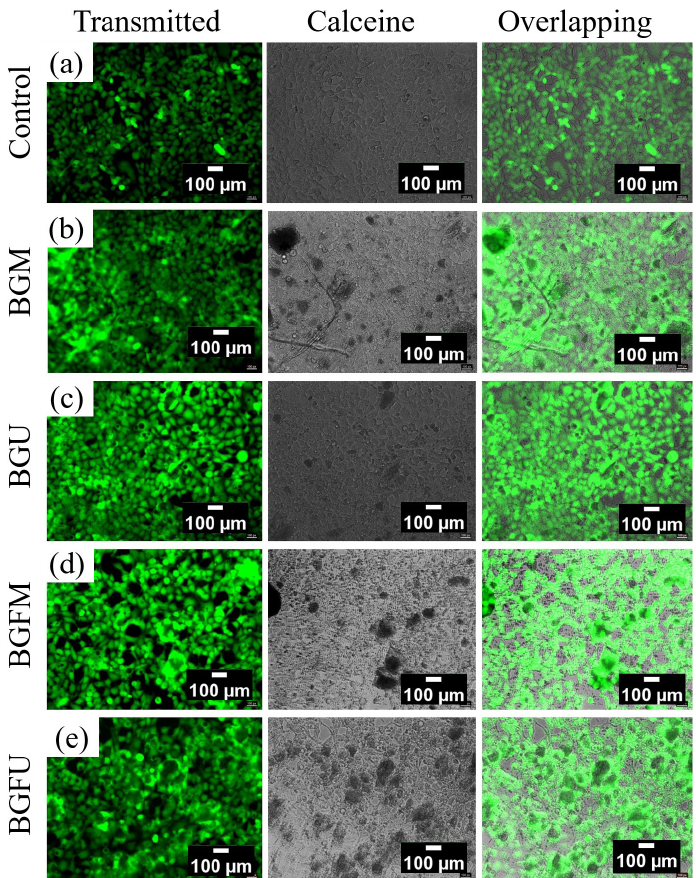
Figure 12. Green fluorescence (viable cells) and transmitted light images of HEK 293 T exposed to the direct contact of bioactive glass samples. (a) Control, (b) BGM, (c) BGU, (d) BGFM and (e) BGFU (Scale bar =